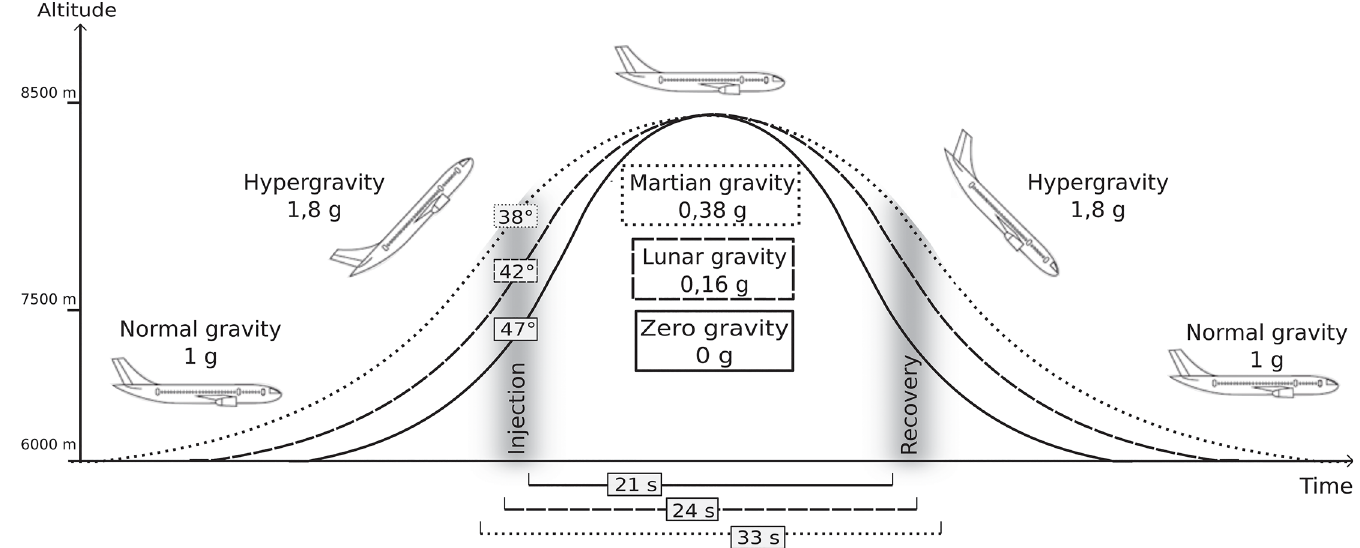
Fig 1. Parabolic flight maneuver and the corresponding acceleration levels according to the aircraft ’ s angle of attack: the flight level (normal gravity) is interrupted by a steep climb flight inducing 20s of hypergravity, followed by 33s of Martian, 24s Lunar or 21s zero gravity and another hypergravity phase before returning to a normal gravity flight level again. "Injection" marks the transition from hypergravity to Lunar /Martian/zero gravity (duration ca. 1s) and "recovery" marks the transition from Lunar /Martian/zero gravity to hypergravity (duration 1s) at the end of the free fall. The different gravitational conditions were used to assess postural control in various unloading and overloading